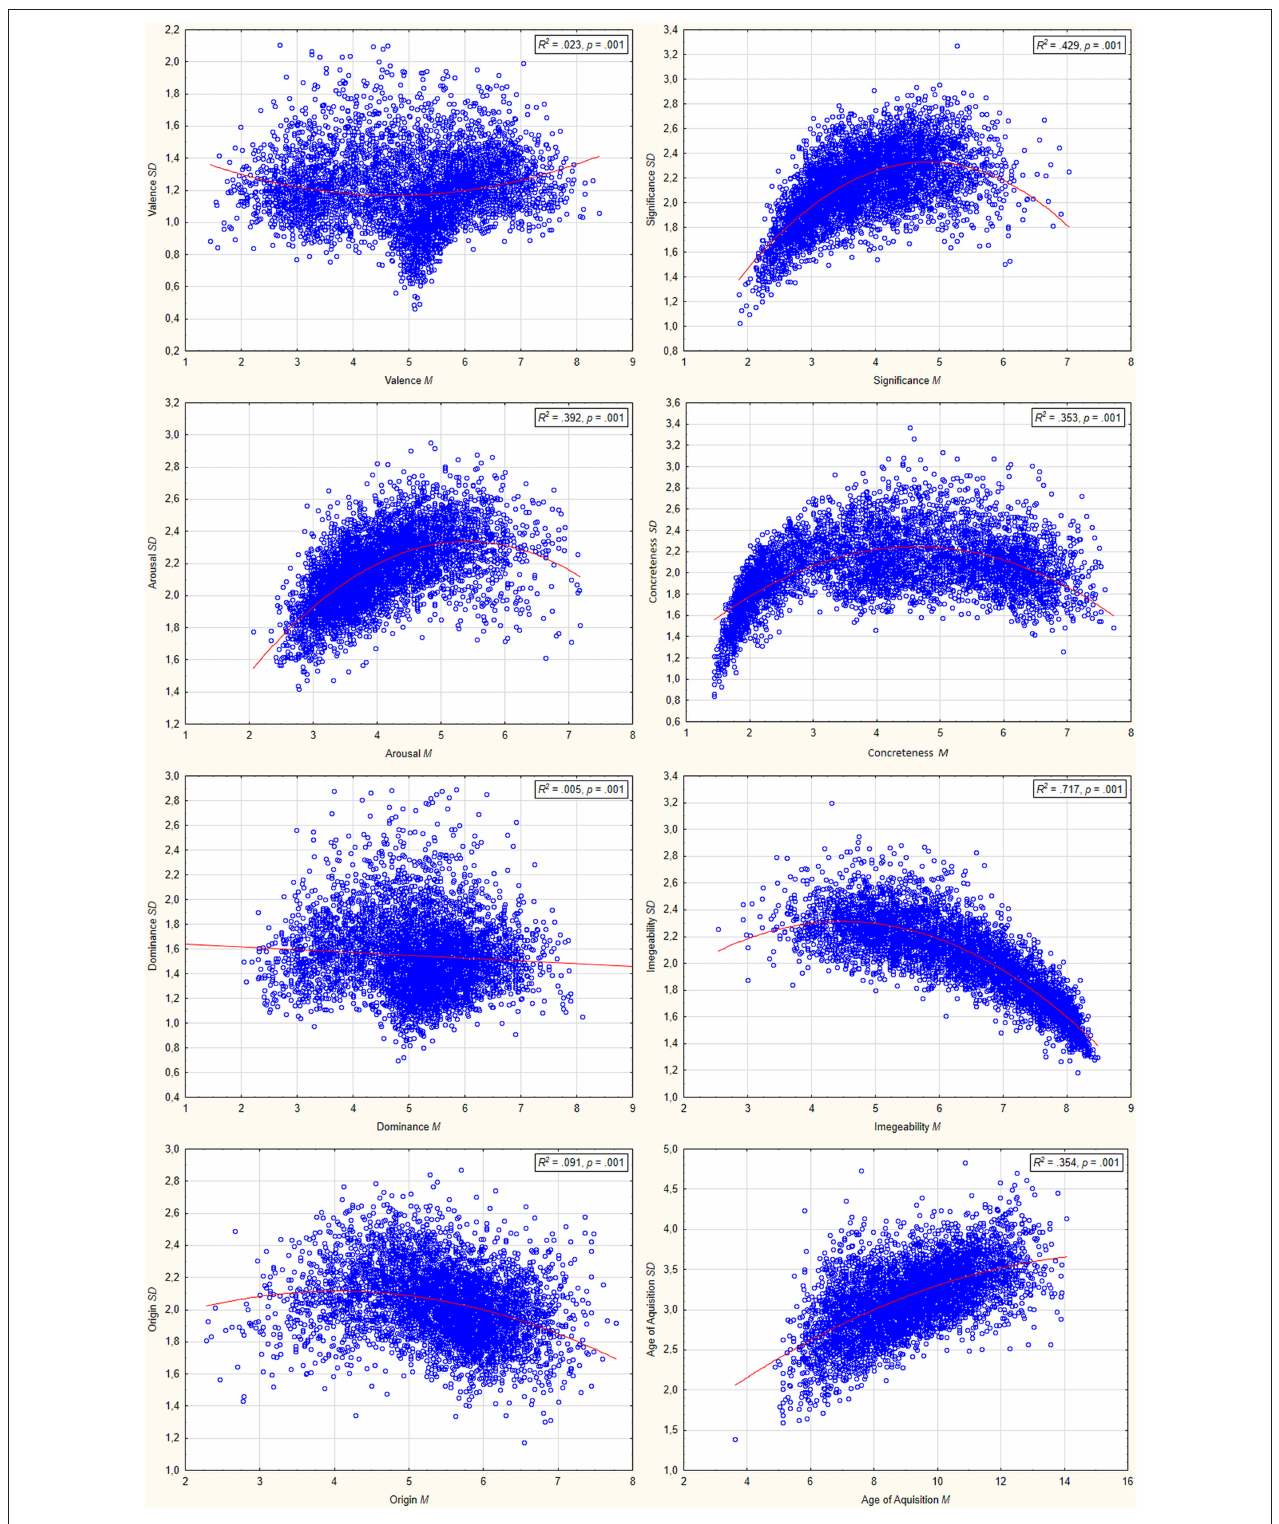
FIGURE 3 | Means ( M ) plotted against standard deviations ( SD ) and function best fitted to the data. In right top corner of each distribution R 2 -value for plotted function.